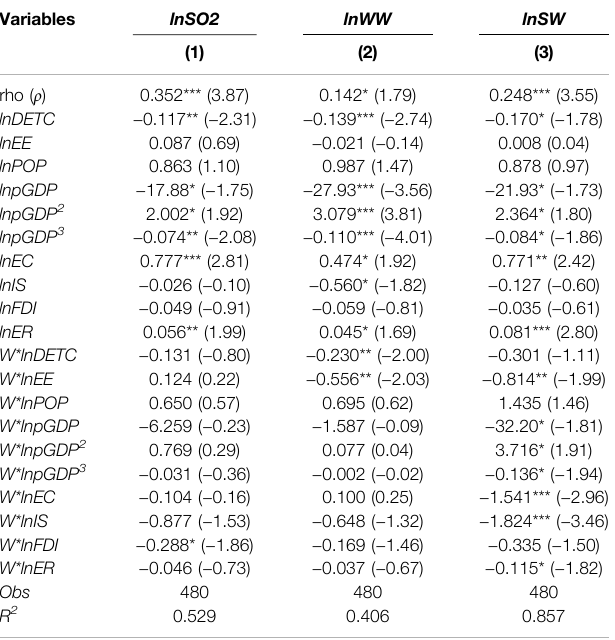
TABLE 6 | Robustness test with different spatial weight matrixes.